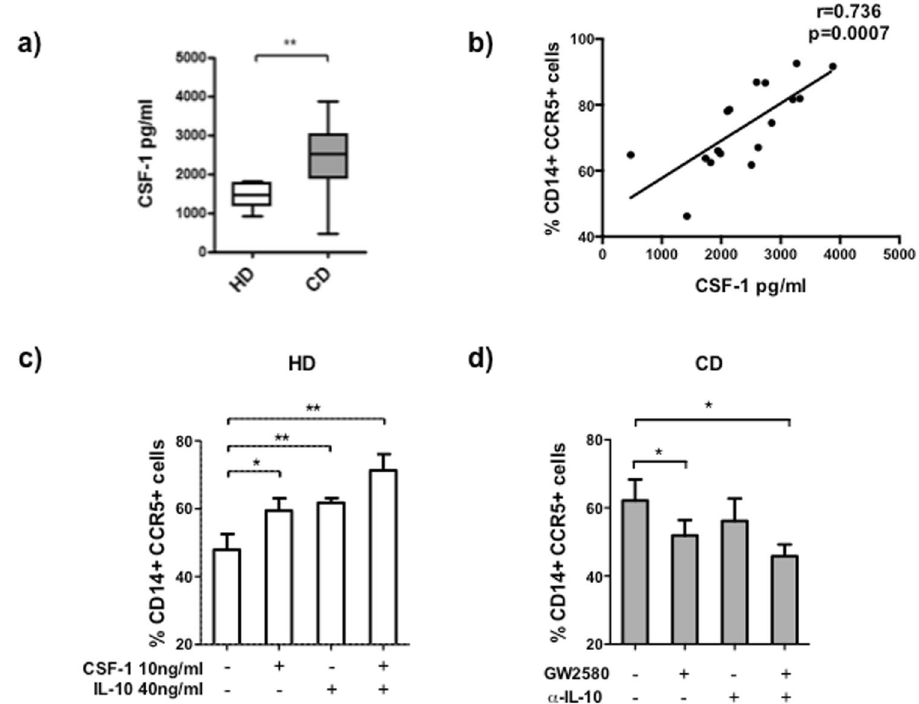
Figure 2. CSF-1 and IL-10 upregulated CCR5 expression on monocytes from HD and CD patients in remission. ( a ) The levels of CSF-1 after 24 h of WB culture of peripheral blood monocytes from HD (n = 14) and CD patients in remission (n = 17) were quantified by ELISA. ( b ) Correlation between CSF-1 levels and the percentage of CD14 + CCR5 + peripheral blood monocytes from CD patients after 24 h of WB culture. ( c ) Peripheral blood monocytes from HD after 24 h of culture with medium, CSF-1 (10 ng/ml), IL-10 (40 ng/ml), or CSF-1 + IL-10 were analyzed by flow cytometry. The results are expressed as a percentage of CD14 + CCR5 + cells. ( d ) Peripheral blood monocytes from CD patients after 24 h of culture in the presence of medium, GW2580 (35 ng/ml), anti-IL-10 (3.5 ng/ml), or GW2580 + anti-IL-10 were analyzed by flow cytometry. The results are expressed as a percentage of CD14 + CCR5 + cells. Mann-Whitney U test was used for the comparison of CSF-1 concentrations between HD and CD patients. Spearman test was used to calculate the correlation between CSF-1 levels and CD14 + CCR5 + cells. ANOVA was used for multiple comparisons of migration in HD (p < 0.0001) and CD (p = 0.05). Wilcoxon test was used for the comparisons between medium and each different condition in HD and CD. ( * p < 0.05, ** p < 0.01, *** p <